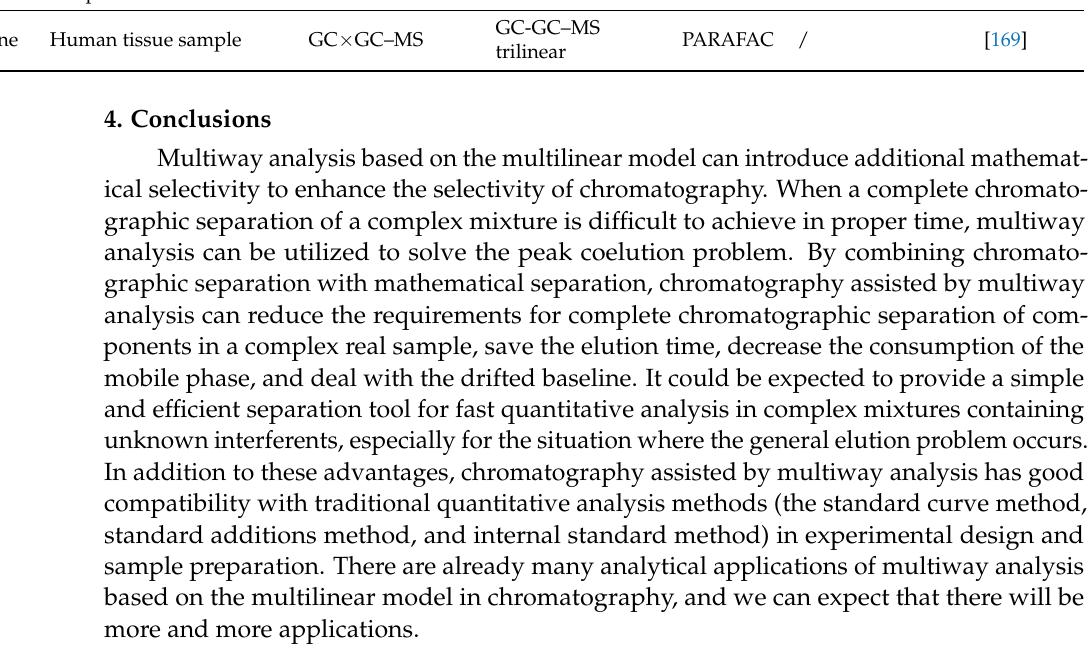
Algorithm Validation